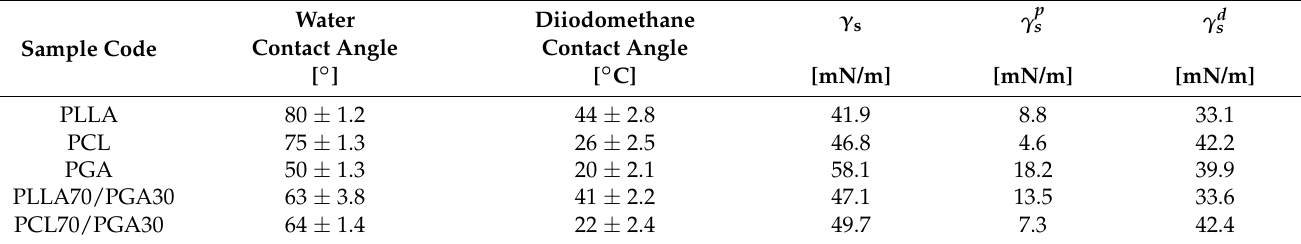
Table 1. Water, diiodomethane contact angles, and surface energies of the neat polymers and of the PLLA70/PGA30 and PCL70/PGA30